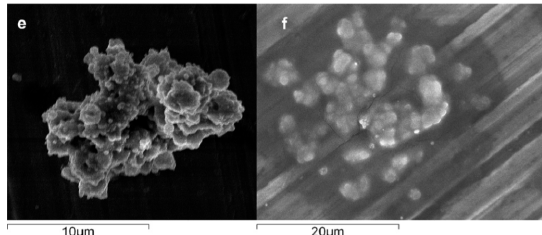
Figure 9. Typical LSM deposits collected on the substrate at the distance 60 mm ( a , b ) and 70 mm ( c – f ) from the plasma torch exit in the single scan experiments. Reproduced with permission from [41], Elsevier, 2013.